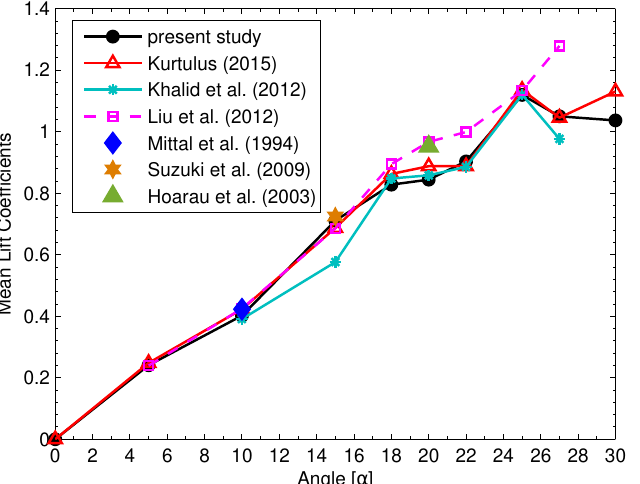
Figure 4. Comparison of time-averaged lift coefficients at different angles of attack with data in literature.